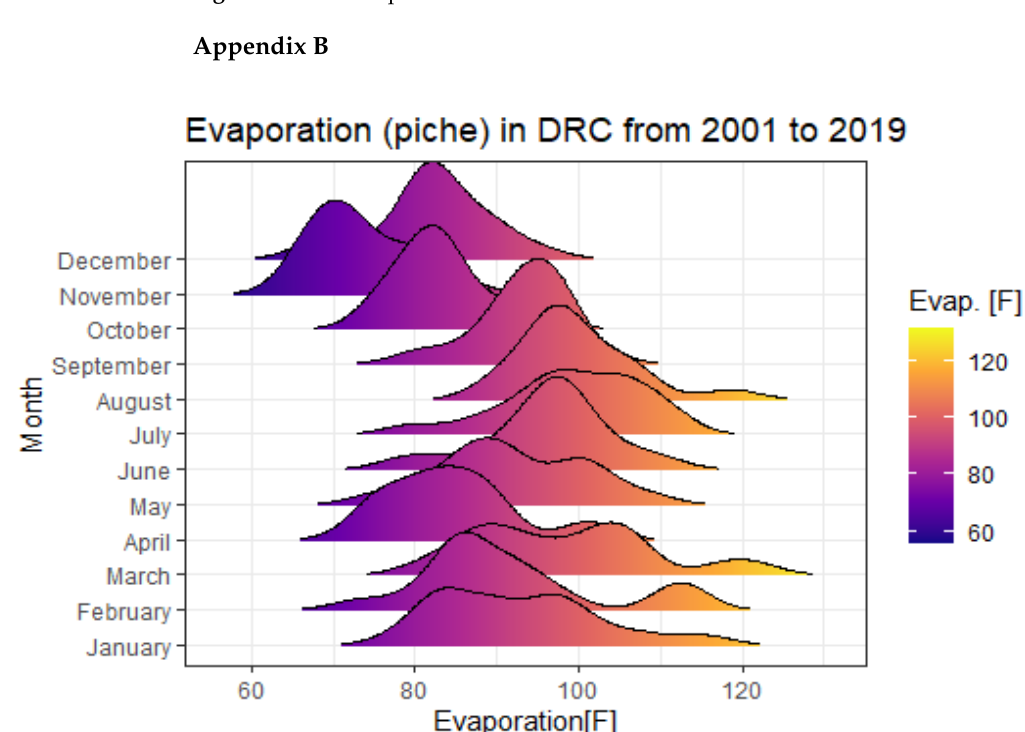
Figure A5. Malaria prevalence forecasts to 2036.